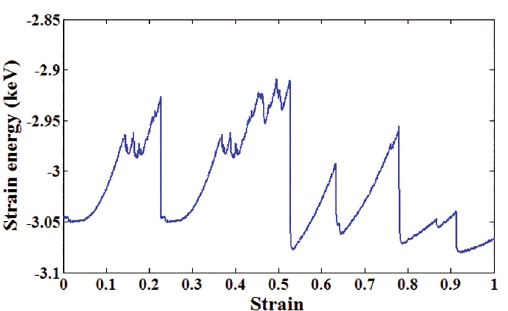
of the systems. Figure 3: Strain energy of a 30×50 Å 2 armchair graphenylene versus strain